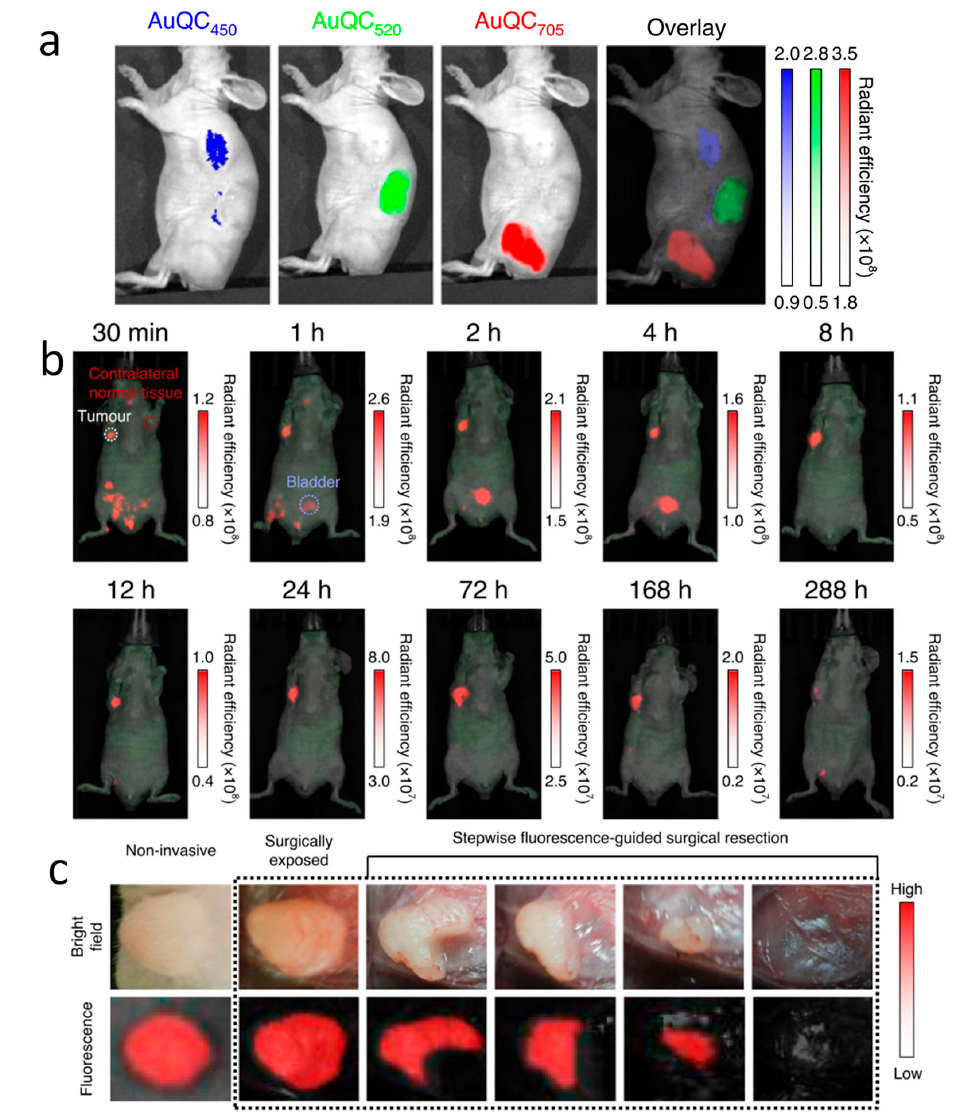
Figure 3. ( a ) In vivo fluorescence imaging of mice after subcutaneous injection of AuNCs with emission at 450 nm, 520 nm, and 705 nm. ( b ) Time course in vivo fluorescence imaging of human breast cancer bearing mice (MDA-MB-231) after injection of AuNC 705 . The renal clearance of AuNC 705 (blue circle, bladder) and the long retention time in tumor (white circle) are highlighted. ( c ) NIR-fluorescence-guided intraoperative surgery after AuNC 705 injection, showing the tumor that was surgically exposed and sequentially removed until the entire tumor was completely removed. Adapted with permission from [69], published by Springer Nature.